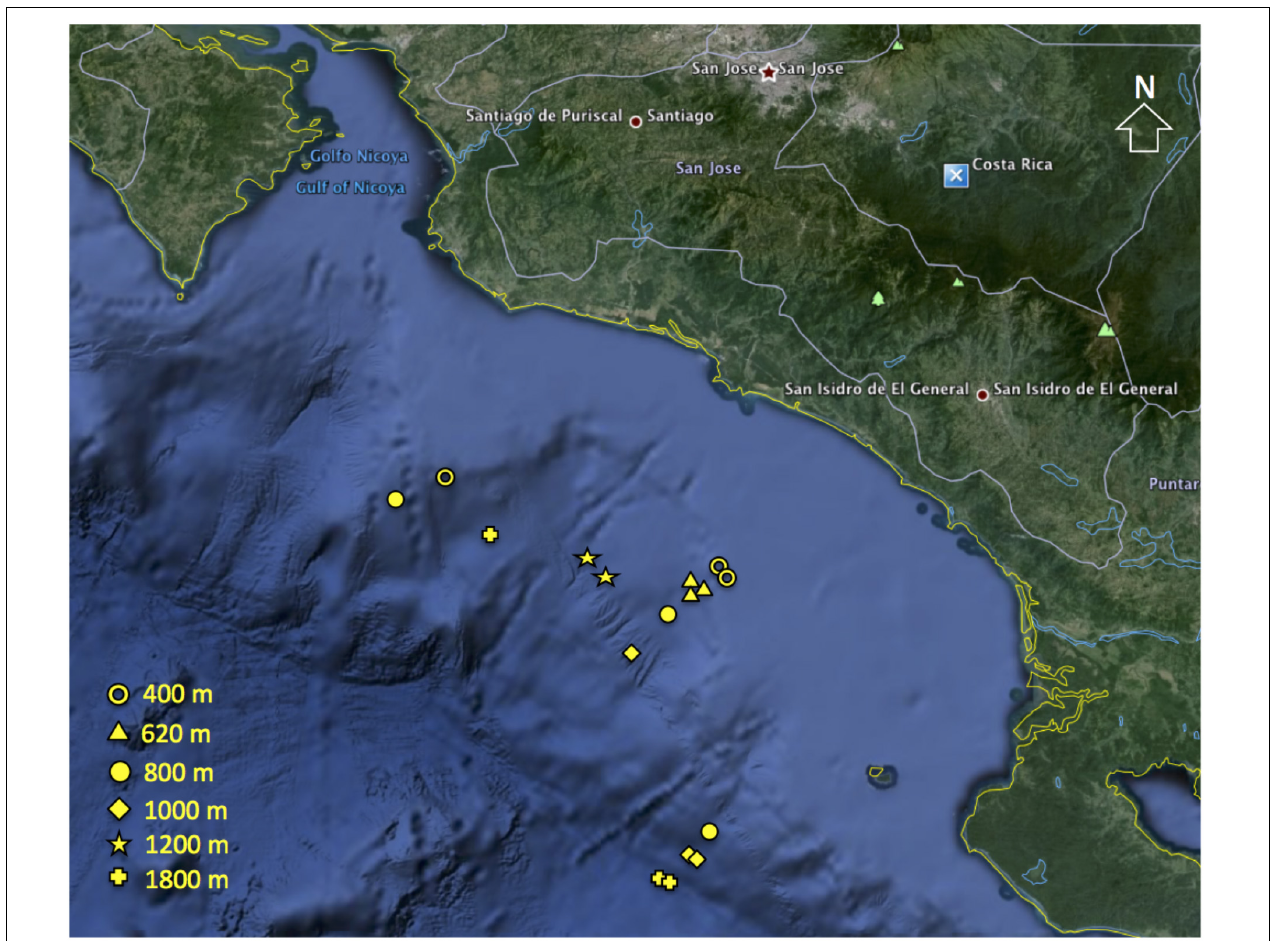
FIGURE 1 | Location of meiofaunal sampling sites along the Costa Rica margin (Map data: 2009 Google Earth).